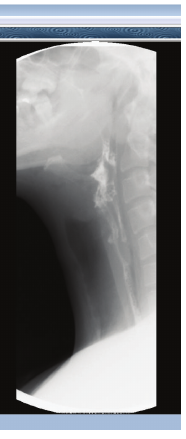
Figure 2: Water soluble contrast swallow showing a posterior hypopharyngeal leak with liquid tracking down the prevertebral